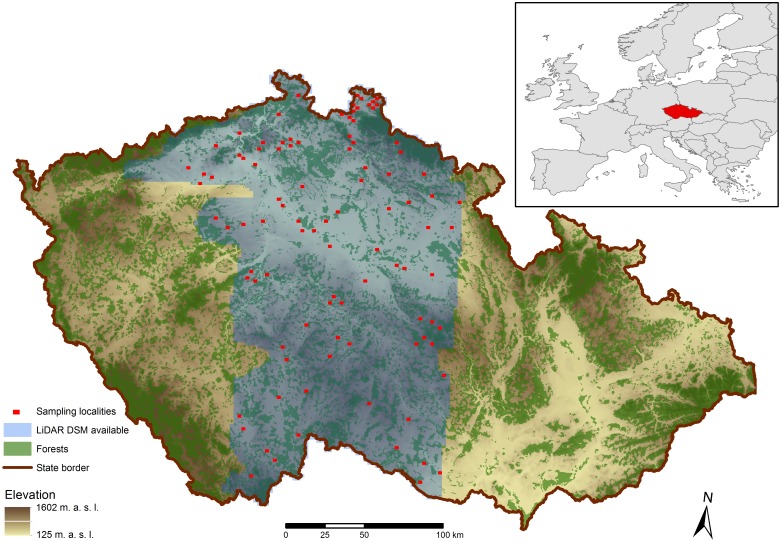
Sampling locations.